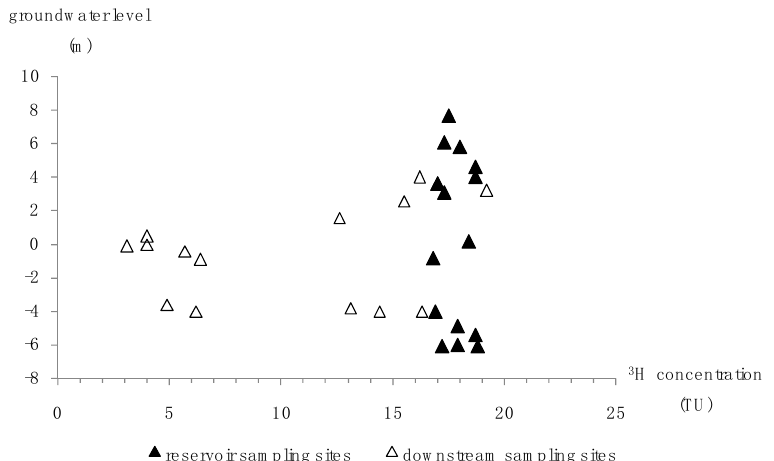
Int. J. Environ. Res. Public Health 2019 , 16 , x Figure 7. Relationship between groundwater level and tritium concentration. Figure 7. Relationship between groundwater level and tritium concentration.